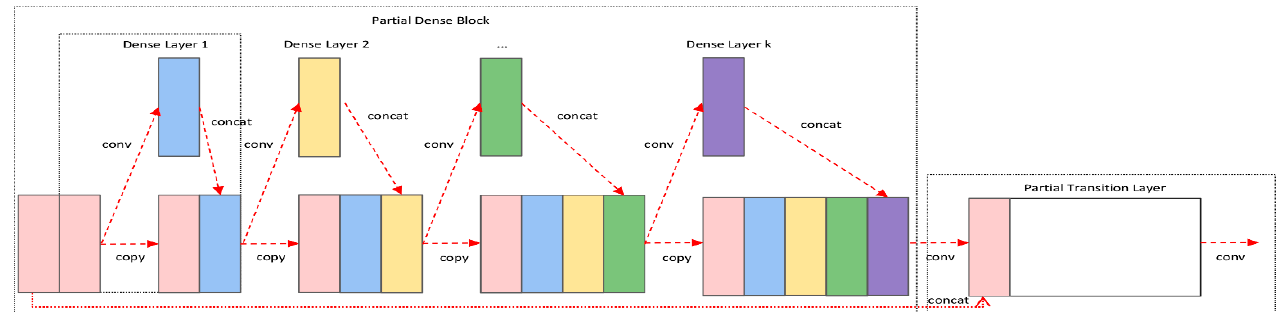
Figure 6. CSPNet module flow chart.